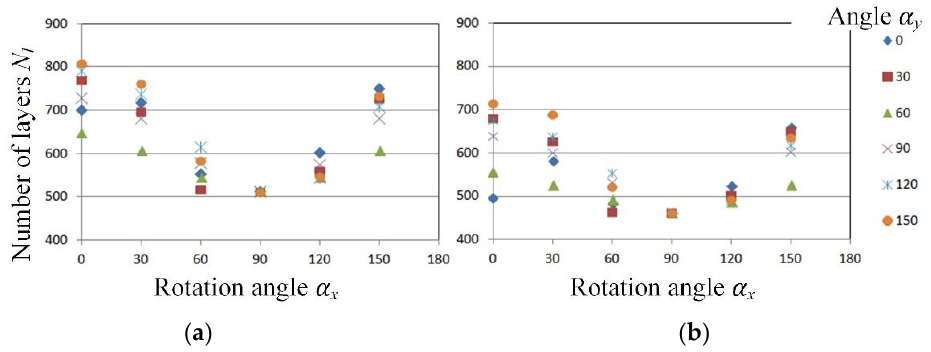
Figure 3. Dependence of the number of building layers N l on the angles α x , α y of rotation of a 3D model coordinate system by slicing with ( a ) constant step and ( b ) variable